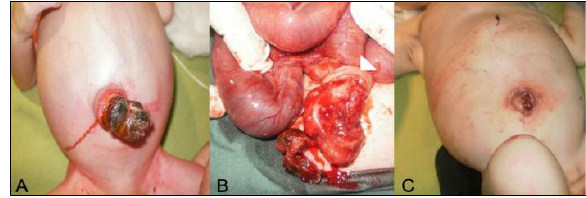
Figure 4: A) Abdominal x-ray showing multiple air- fluid levels. B, C) Transected terminal ileum herniating through the umbilical ring. D) Exploration identified it as terminal ileum.